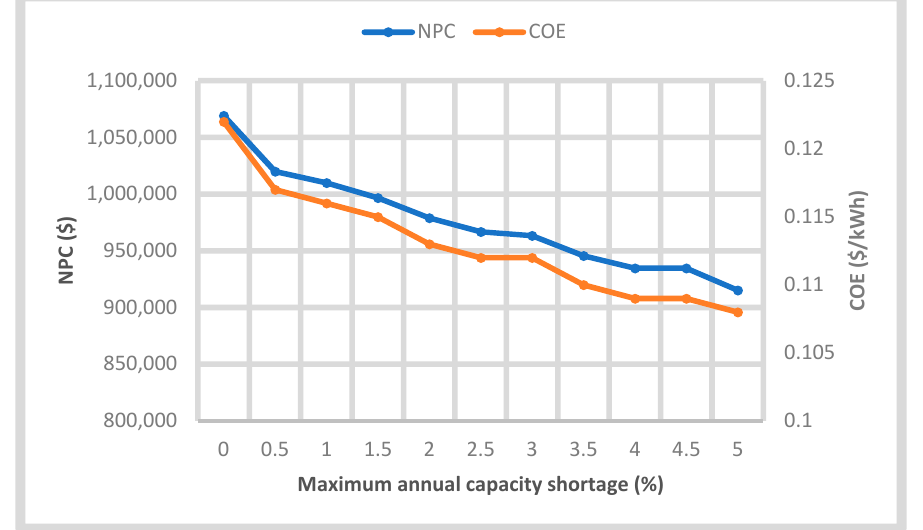
Figure 17. Impact of increasing the maximum annual capacity shortage on the NPC and COE of the system.